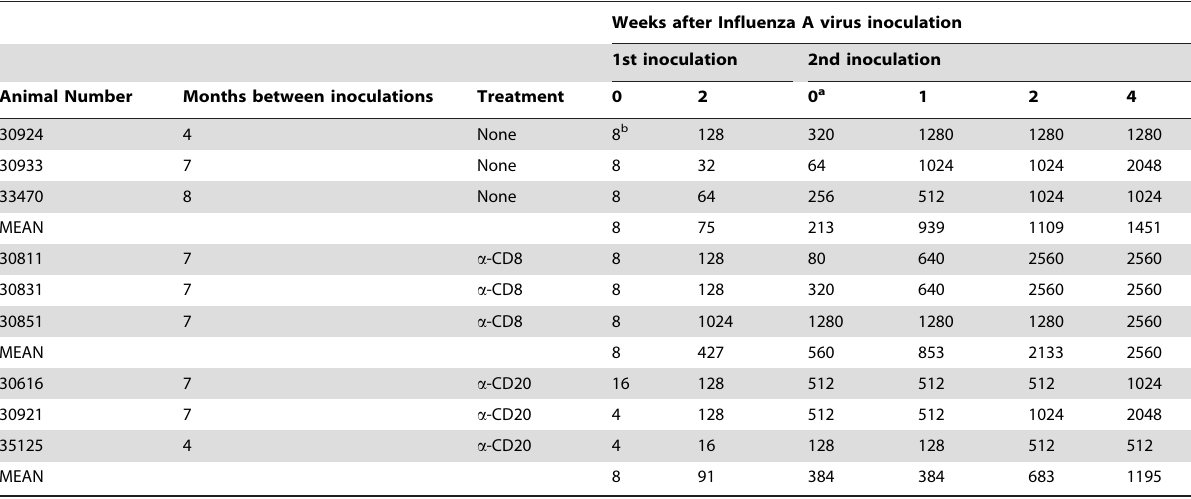
Table 2. HI titers in plasma after the first and second inoculations with A/Memphis/7/01.